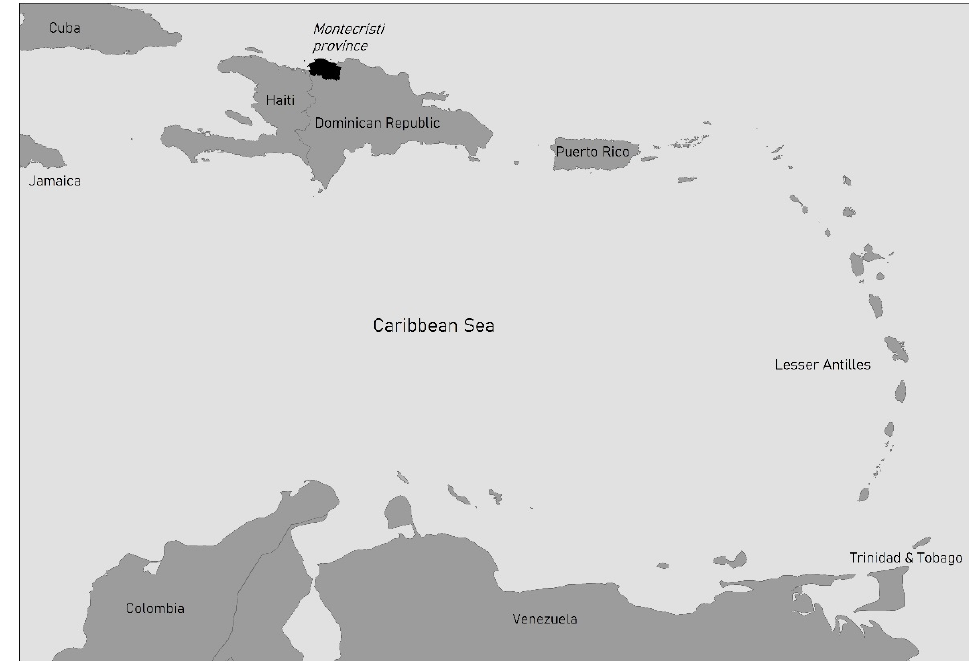
Figure 1. The province of Montecristi (Dominican Republic) in the context of the contemporary Caribbean.